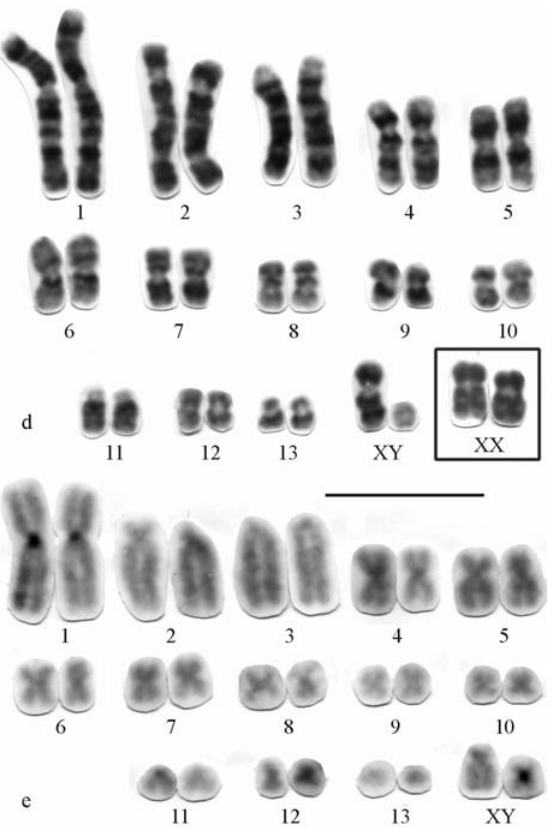
Figure 3(d-e) - Karyomorph A with 2n = 28, FN = 48: d) G-banding pat- tern; e) C-banding pattern of P. longicaudatus from Aripuanã and Juruena (MT). Bar = 10 (cid:1) m.